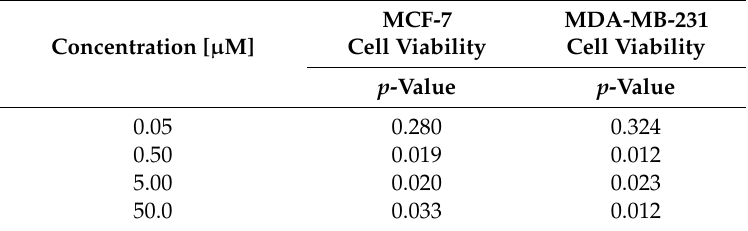
Table 3. ANOVA P-Values for ultra-large MCF-7 and MDA-MB-231 spheroid cell